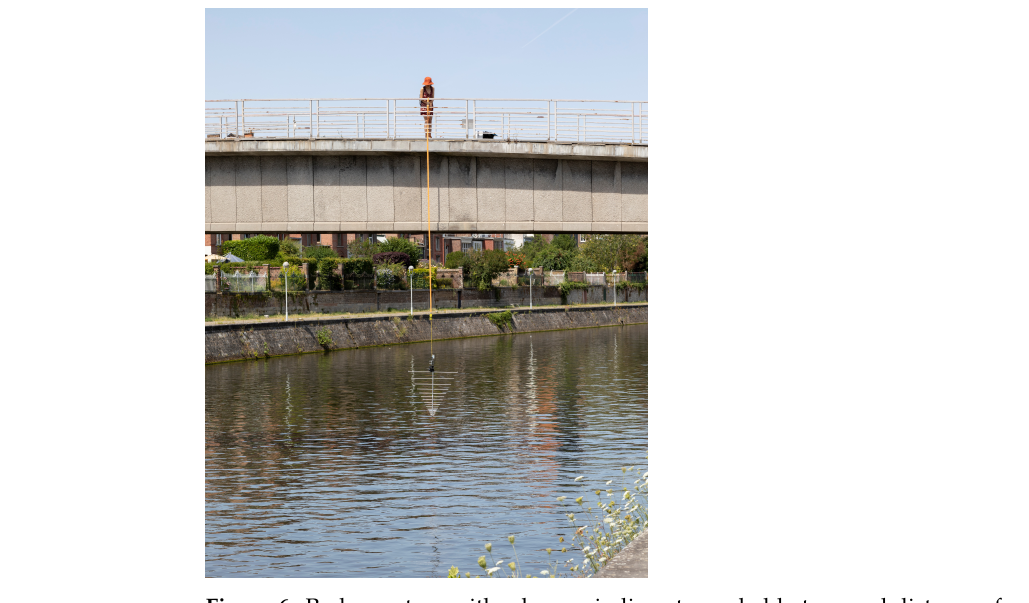
Figure 6. Radar system with a log-periodic antenna held at several distances from a water plane to determine the antenna characteristic functions R i ( ω ) , T ( ω ) , and R s ( ω ) (antenna calibration). The radar measurements were performed in the 80–1000 MHz frequency range.